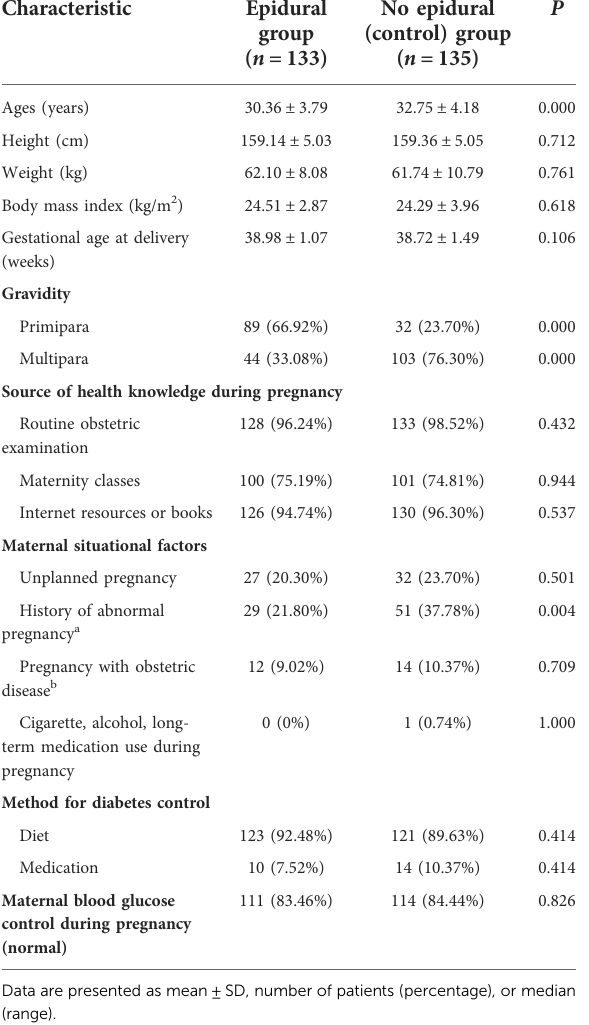
TABLE 1 Baseline demographic and obstetric characteristics of parturients who completed the study. Characteristic